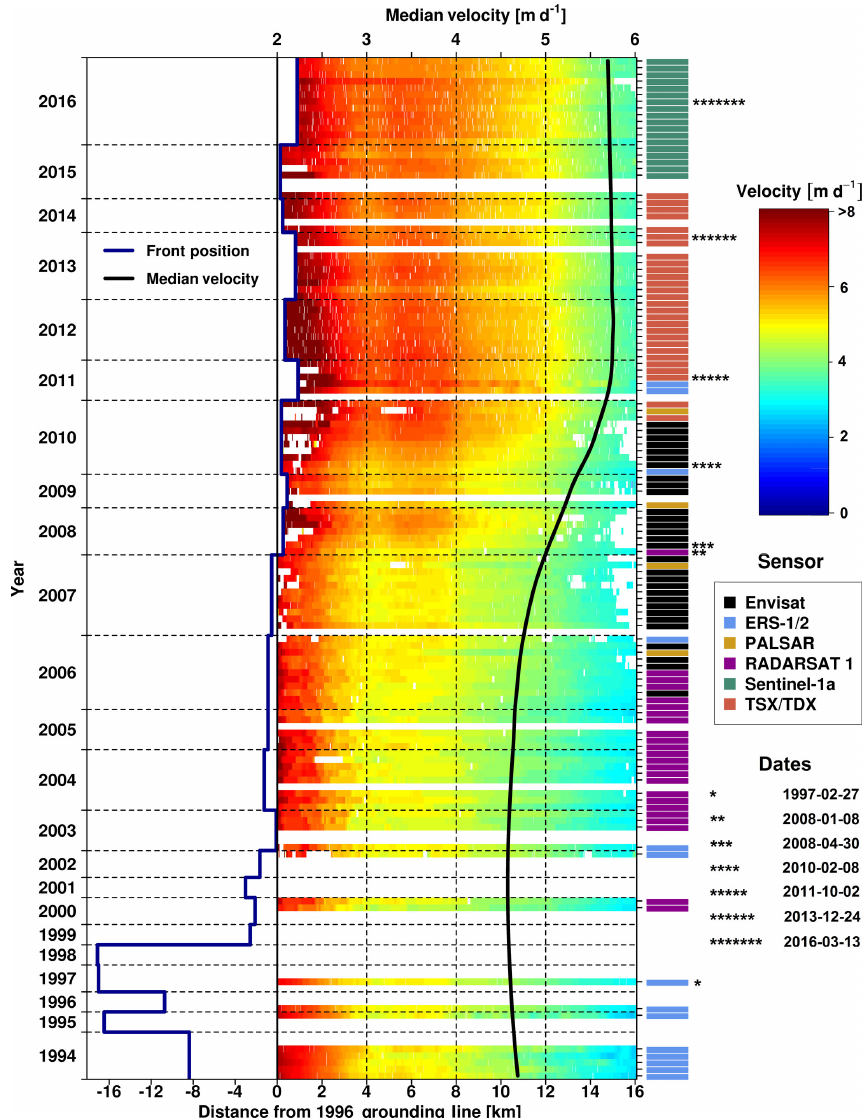
Figure 2. Left side (blue line): relative distance of the glacier front to the grounding line position in 1996. See Table S1 for data used for front mapping. Right side: velocity time series and smoothed median velocities (black line) derived from multi-sensor SAR intensity tracking along a centre line profile on Fleming Glacier starting at the 1996 grounding line (Fig. 1). Dates mentioned in the text and in Fig. 3a, b are indicated with black stars. For all other dates see Table